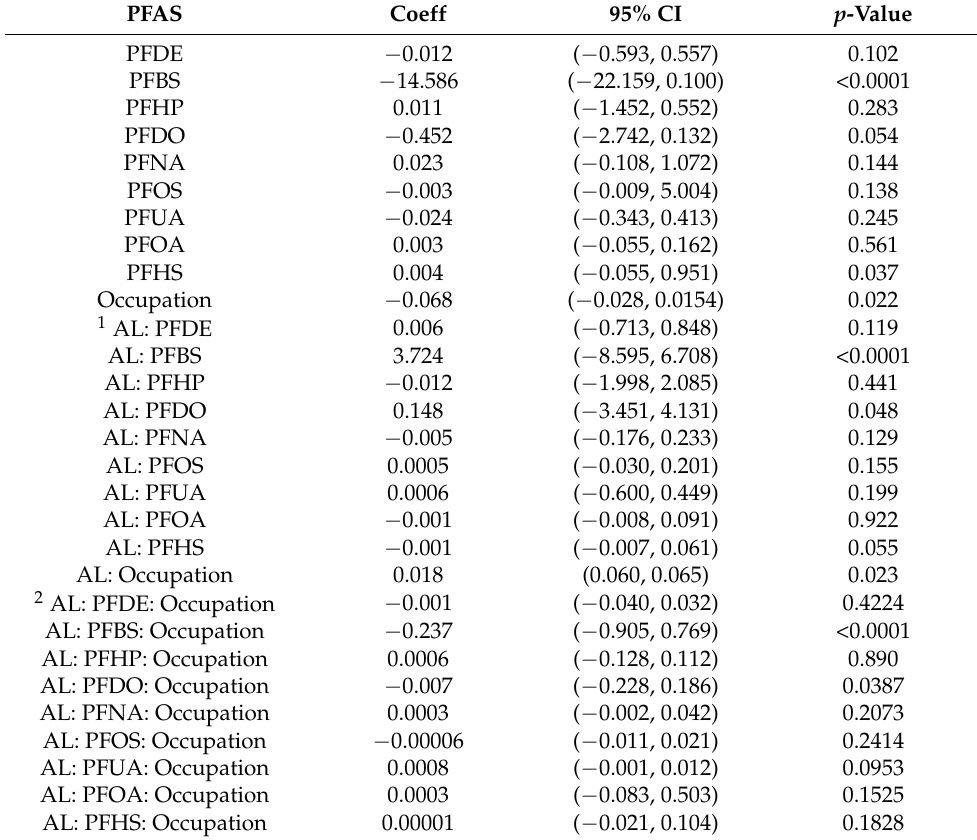
Table 7. Poisson regression model to assess the interactions of occupation with PFAS and